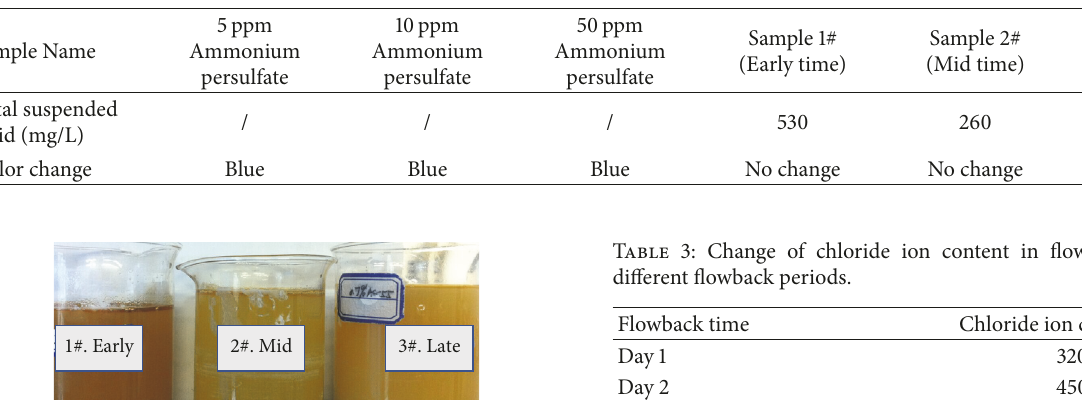
Table 2: Analysis of total suspended solids and residual gel breakers in the flowback fluid in Tarim Oilfield.